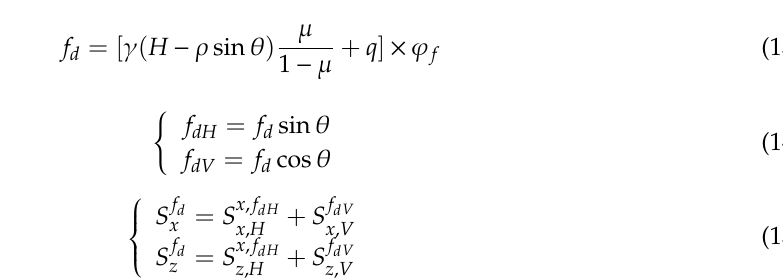
Figure 9. Horizontal displacement of stratum caused by q .